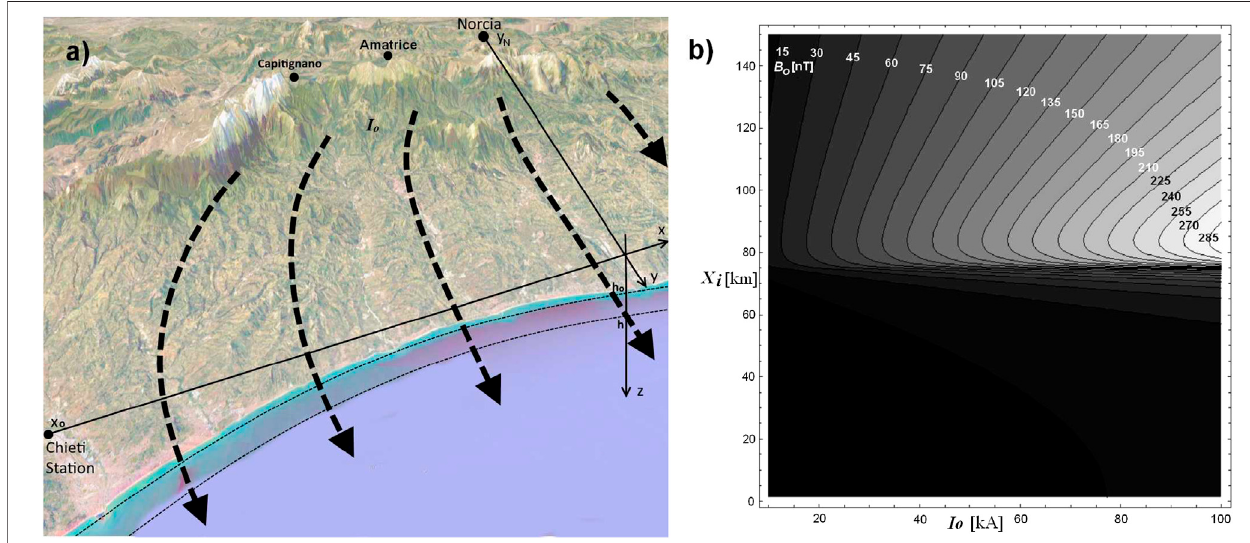
FIGURE 12 | The model of electrical currents fl owing from the Apennines around the hypo-centre to the Adriatic Sea through the conductive clay layer with the system coordinates in (A) ; the Chieti Station is at x o (cid:1) − 75 km while Norcia is at y N (cid:1) − 65 km. The retrieved magnetic fi eld B o in the position of Chieti due to the total current I o , fl owing through the conductive layer thickness h – h o (cid:1) 5.9 km of width between -x i and x i , in a contour plot (B) .